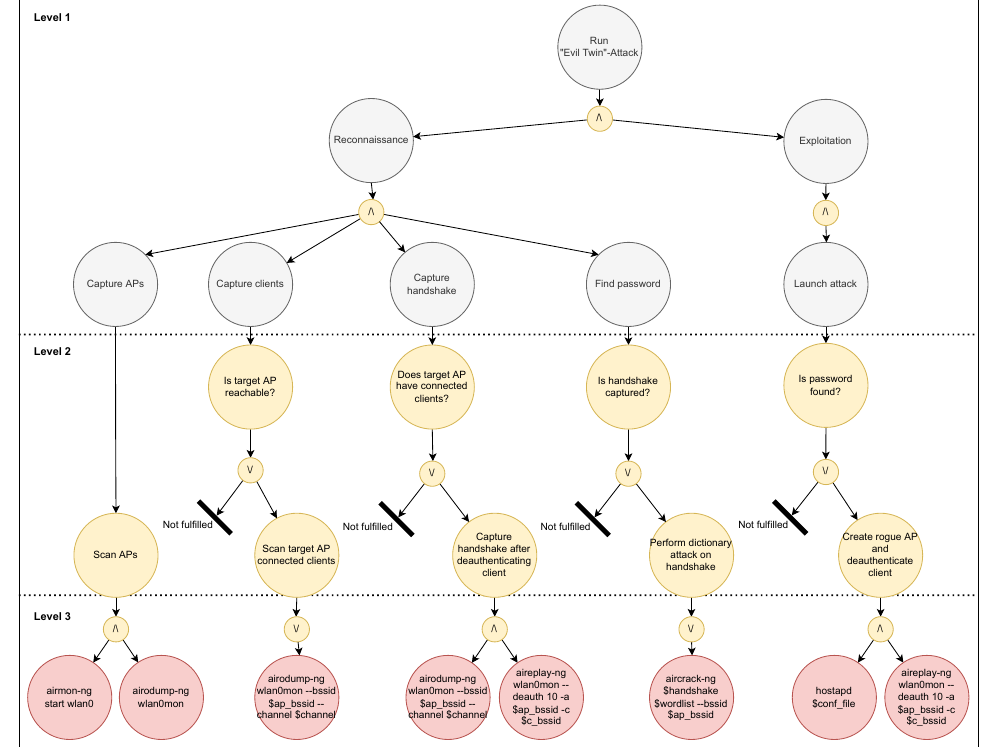
Figure 16. EP model of the Evil Twin